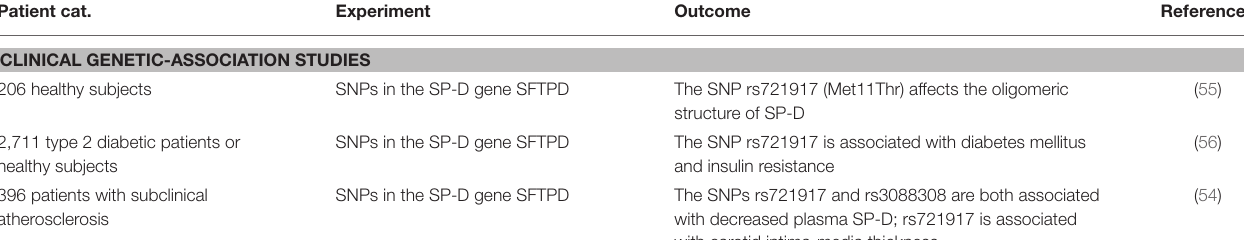
expression by rhSP-D (45). The identification of SP-D as a down- regulator of serum IL-6 and TNF- α is in agreement with the observations in Liu et al.